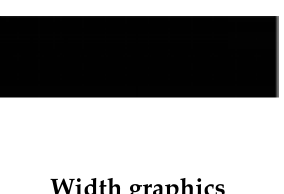
Figure 7. Examples of graphics as priming images in Experiment 3a.